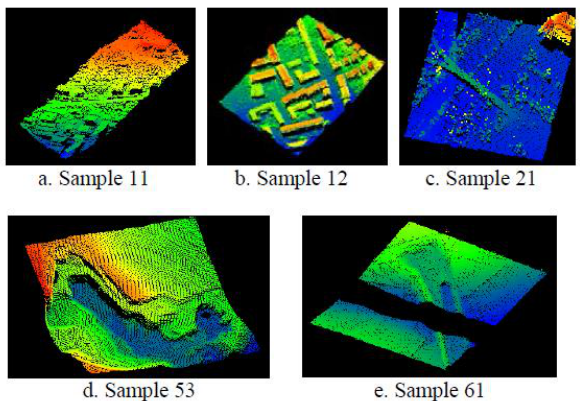
Figure 1. ISPRS testing samples: (a) steep terrain, (b) dense buildings, (c) bridge, (d) height discontinuity and (e)